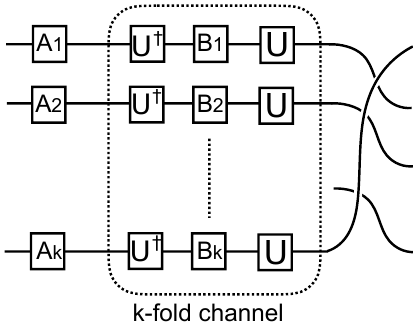
Figure 1 . Schematic form of the 2 k -point OTO correlation functions eq. (3.1), interpreted as a correlation function on the enlarged k -copied system. The dotted line diagram surrounds the k -fold channel (cid:8) E ( B 1 B k ), which is probed by A 1 : : : A k . (Periodic boundary conditions are (cid:10) (cid:1) (cid:1) (cid:1) (cid:10) (cid:10) (cid:10) implied to take the